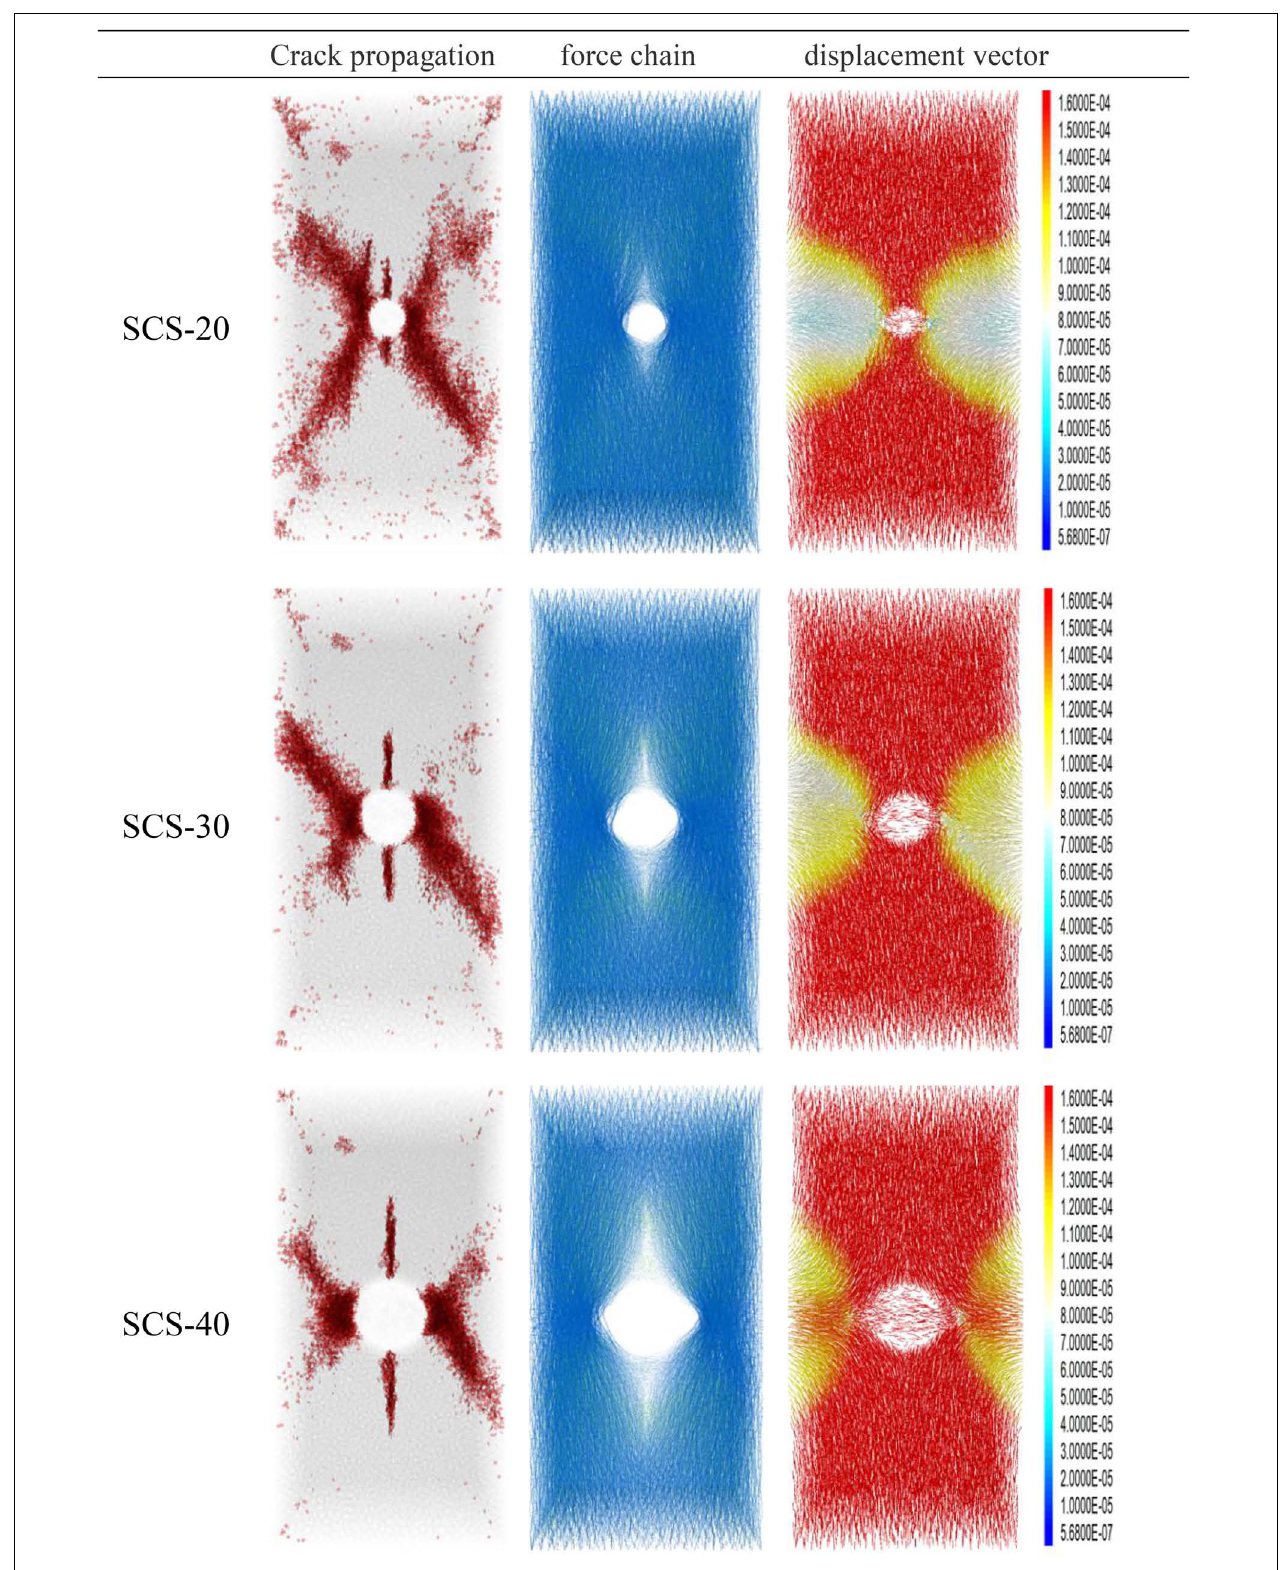
FIGURE 6 | Crack propagation, force chain distribution, and displacement vector diagrams of SCS-20, SCS30, and SCS-40 at the peak of axial stress under triaxial cyclic load.